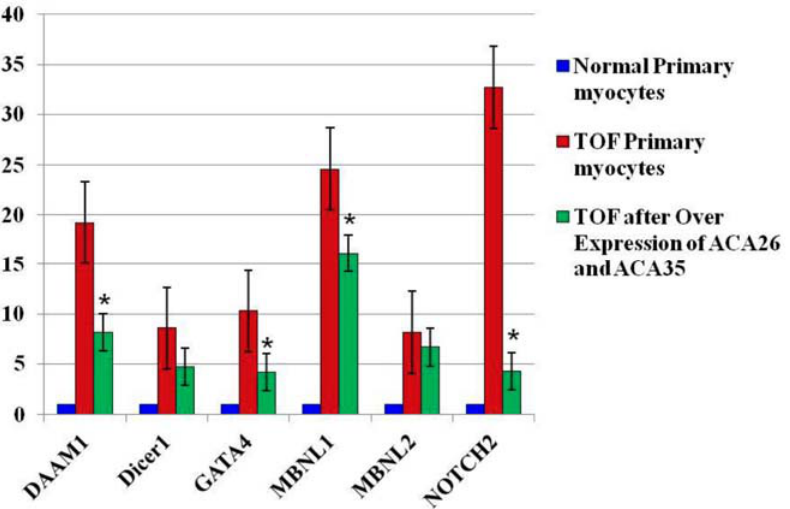
Figure 2. Fetal ‐ type splice isoforms are reduced after overexpression of scaRNAs. Data are fold change of exons that represents regions of variability within the alternatively spliced gene. Each value is derived from the mean intensity level from three different primary myocyte cell lines (3 biological replicates with 3 technical replicates for each individual gene analyzed by qRT ‐ PCR). The normal comparison cells (blue) provide a reference point for comparisons between the sham transfected TOF cells and those with the expression vectors. * significantly different from levels in sham transfected TOF primary cells. The TOF primary cells were derived from three different infants and each PCR included 3 technical replicates. Expression plasmids pCGL ‐ ACA26 and pCGL ‐ ACA35 were a